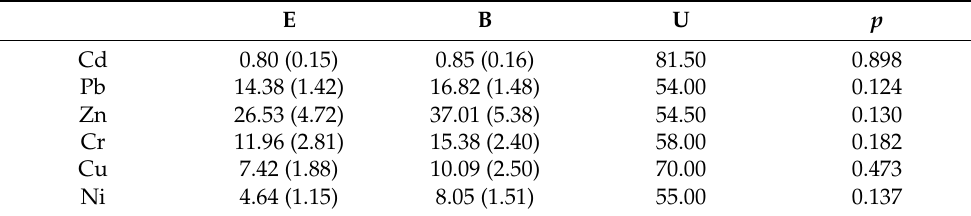
Table 5. The mean content of trace element in E and B horizons, standard error (the value in parentheses), and the U and p value estimated by the Mann–Whitney U